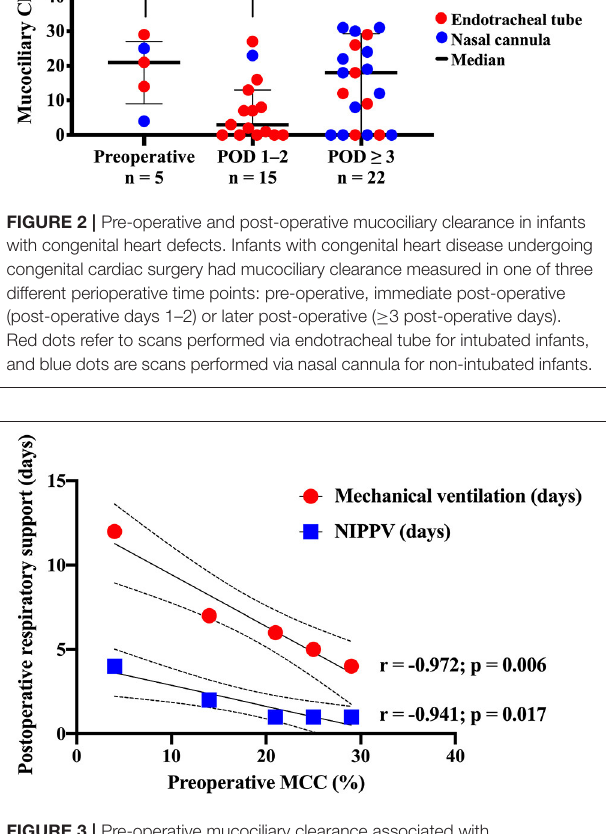
FIGURE 3 | Pre-operative mucociliary clearance associated with post-operative respiratory support. Significant inverse correlations were observed between the percentage of pre-operative mucociliary clearance and post-operative days requiring mechanical ventilation (red dots) and non-invasive positive pressure ventilation (blue squares).